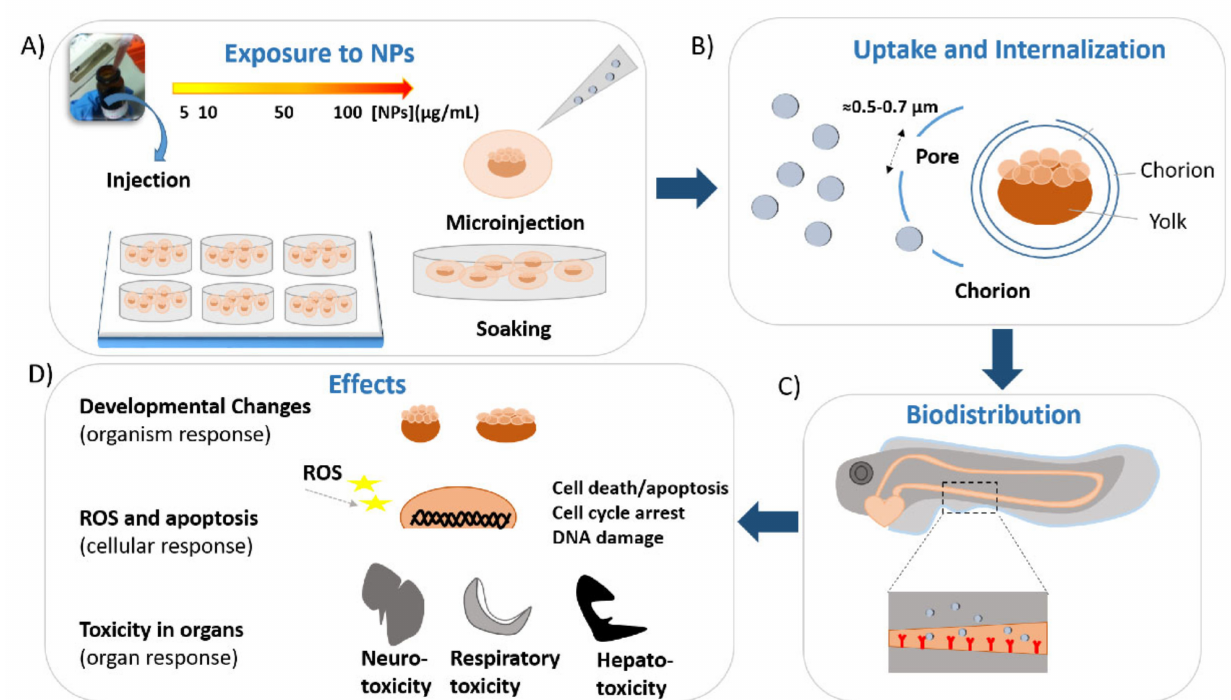
Figure 1. Action mechanisms of nanoparticles on zebrafish. ( A ) Exposure of eggs to nanoparticles dissolved in embryo medium by simple soaking or direct microinjection; ( B ) uptake and internalization of nanoparticles in zebrafish eggs by passive diffusion through the chorion pores (500–700 nm); ( C ) nanoparticles enter the circulatory system and accumulate in different tissues and organs; ( D ) effects of nanoparticles on zebrafish at different levels: organism (developmental changes), cells (ROS generation and apoptosis), and organs (neurotoxicity, respiratory toxicity, and hepatotoxicity). Abbreviation: NPs: nanoparticles; ROS: reactive oxygen